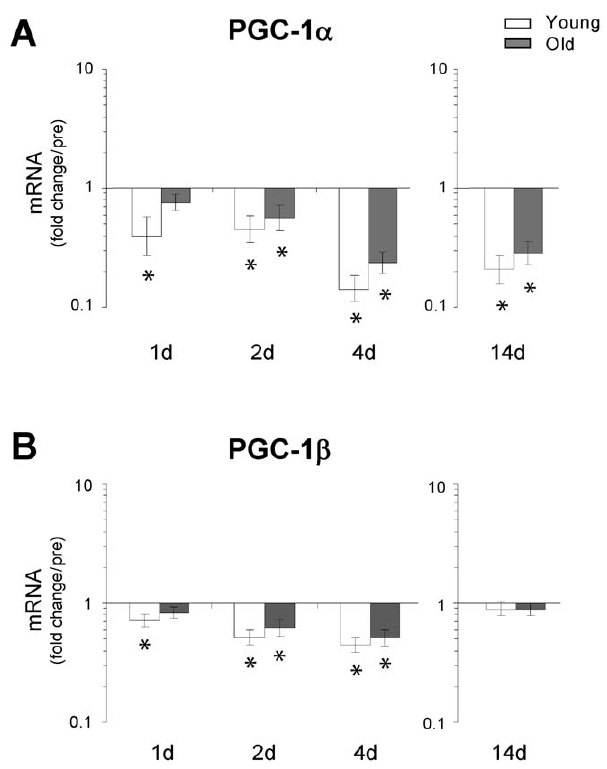
Figure 7. Changes in the transcriptional status of PGC-1 a and PGC-1 b as a result of immobility-induced disuse-muscle atrophy. The mRNA level of PGC-1 a and PGC-1 b was determined using qRT-PCR. A. The results revealed a marked down-regulation of PGC-1 a at 24 h in young muscle and a down-regulation in both young and old muscle at the later time points (2 d, 4 d and 14 d). B. The expression levels of PGC-1 b mRNA also revealed an age-specific down- regulation after 24 h in young muscle and a down-regulation in both young and old muscle at 2 d and 4 d. In contrast to PGC-1 a , the expression levels of PGC-1 b mRNA returned to basal levels at 14 days of immobilization, indicating that the two genes may play different roles in the later stages of muscle unloading. * Time effect, p , 0.05 compared to pre. Data are geometric means 6 back-transformed SEM.